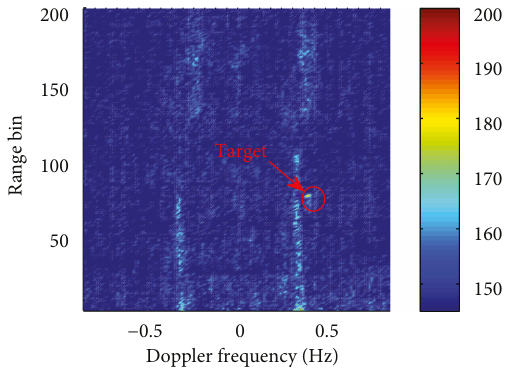
Figure 20: Range-Doppler map by the IMLC